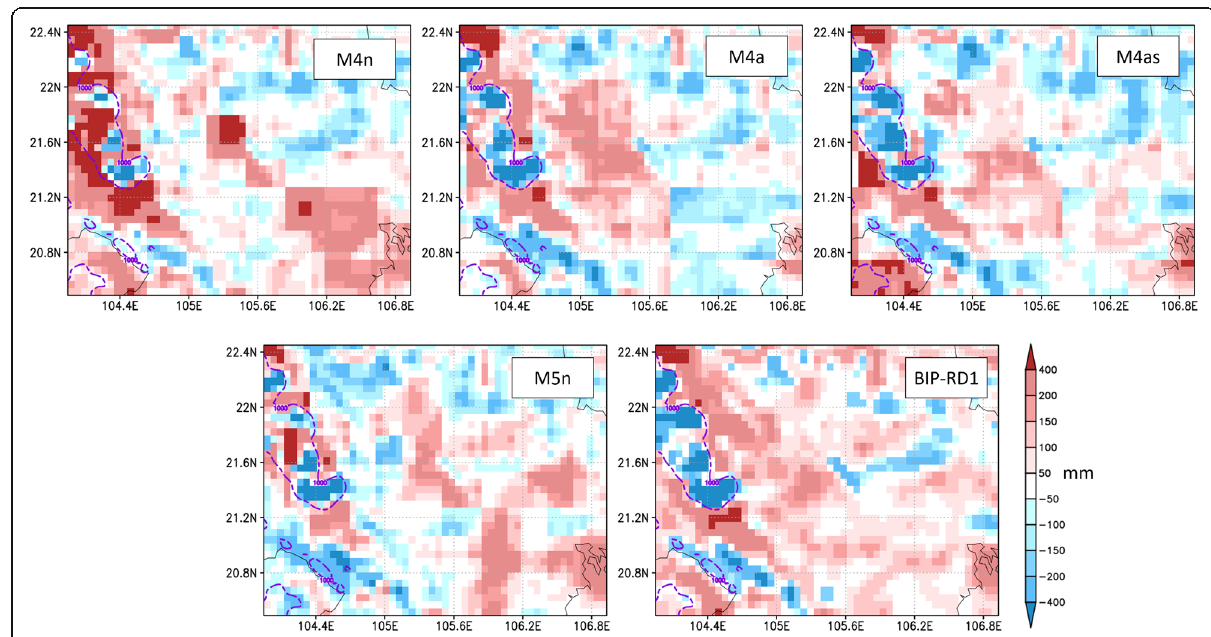
Fig. 9 Differences between simulations in cumulative rainfall (mm) in JJA of 2006 results and RD2T. The purple contour dash lines indicate the areas with terrain height of over 1,000